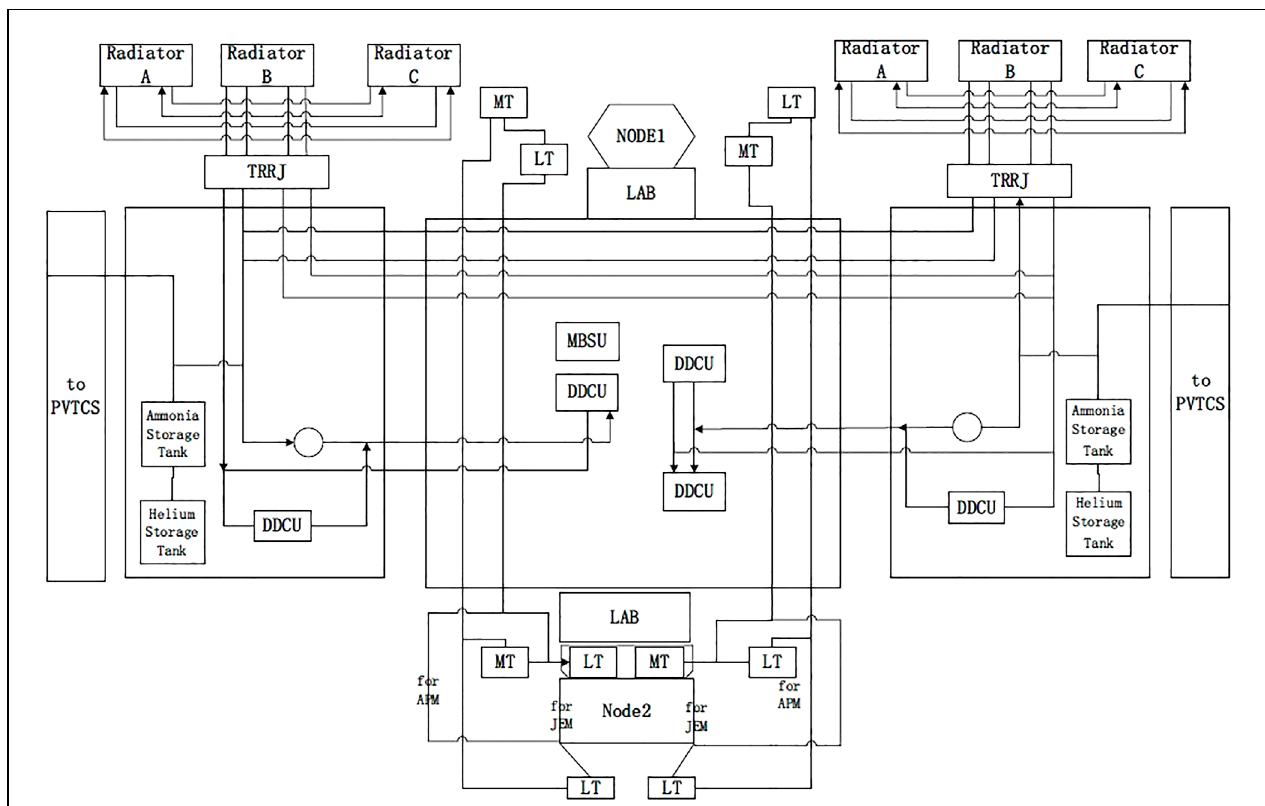
FIGURE 2 | Schematic diagram of thermal bus for international space station.